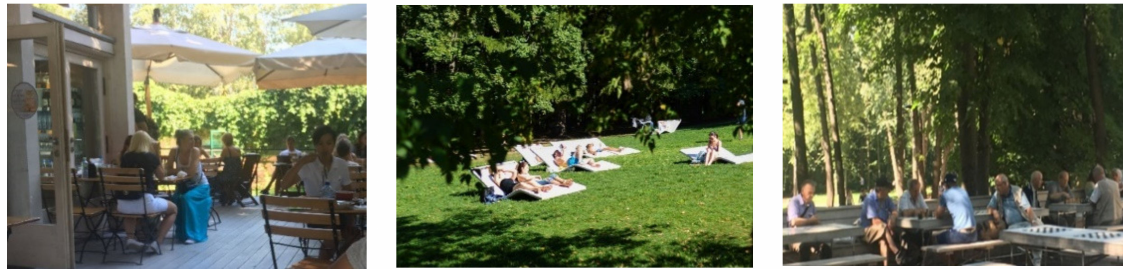
Figure 9. UGS as a space for physical exercises and outdoor sport activities (Photos: D. Dushkova).